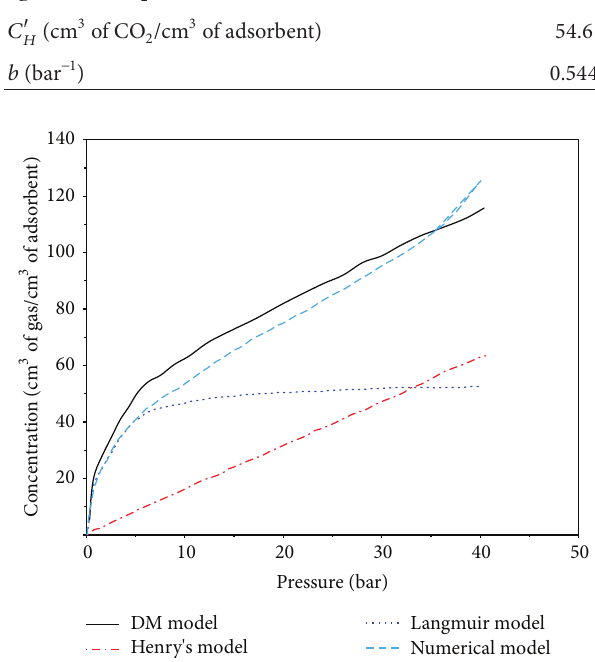
Figure 2: Comparison of DM model and numerical